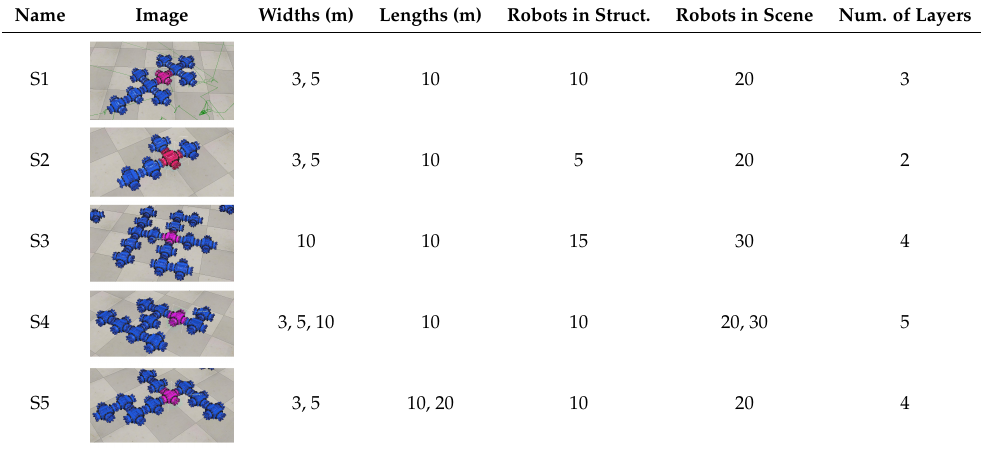
Table 1. Table of structures formed; the seed robot in each structure being highlighted in pink. Comma-separated numbers in columns indicate that multiple values were